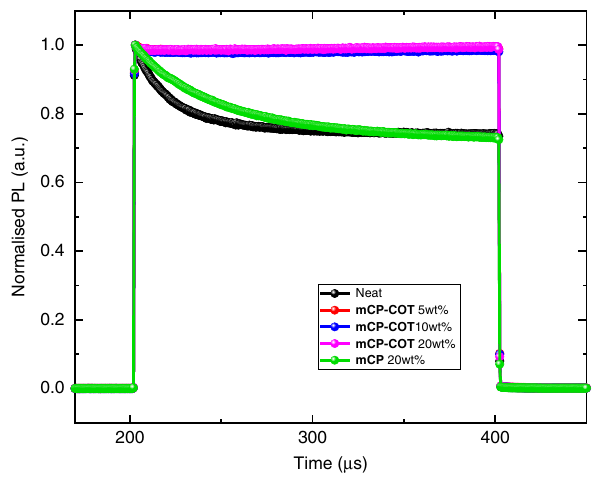
Fig. 4 Transient PL of BSBCz-EH neat and blend fi lms. Characteristics of encapsulated BSBCz-EH neat fi lm (black line) and blend fi lms with different mCP-COT blending concentrations [5 wt% (red), 10 wt% (blue), and 20 wt % (pink)], which can be compared with its blend fi lm with 20 wt% in mCP (green). Excitation wavelength = 355 nm; laser beam excitation power = 2.65 mW; pulse width = 200 µ s and pulse interval = 10